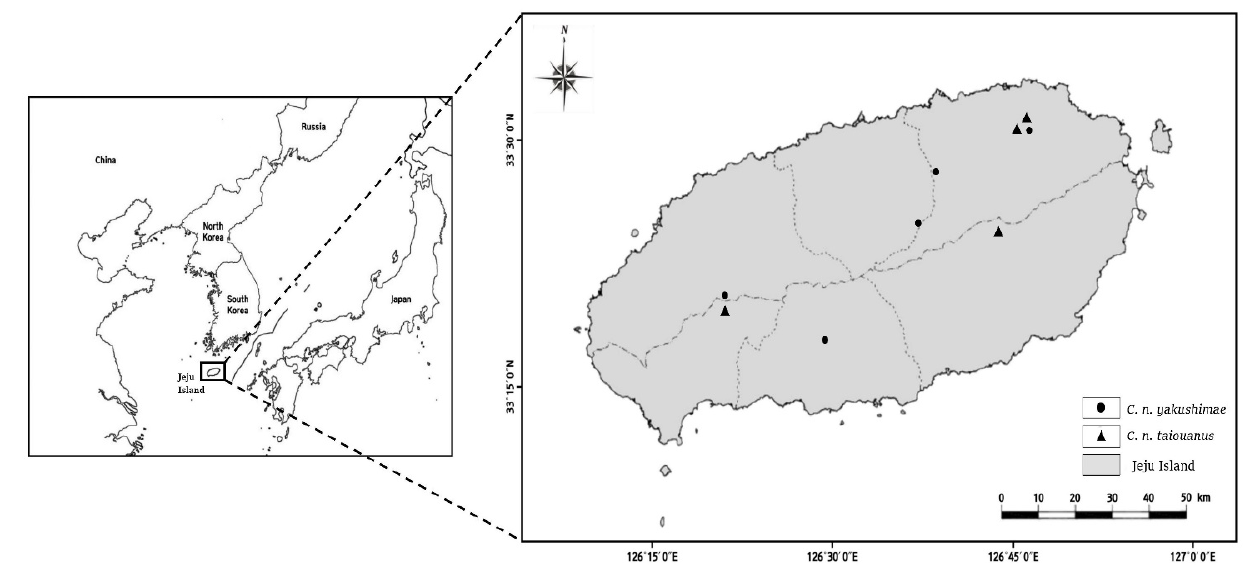
Figure 1. Map of Jeju Island showing samples collection sites.